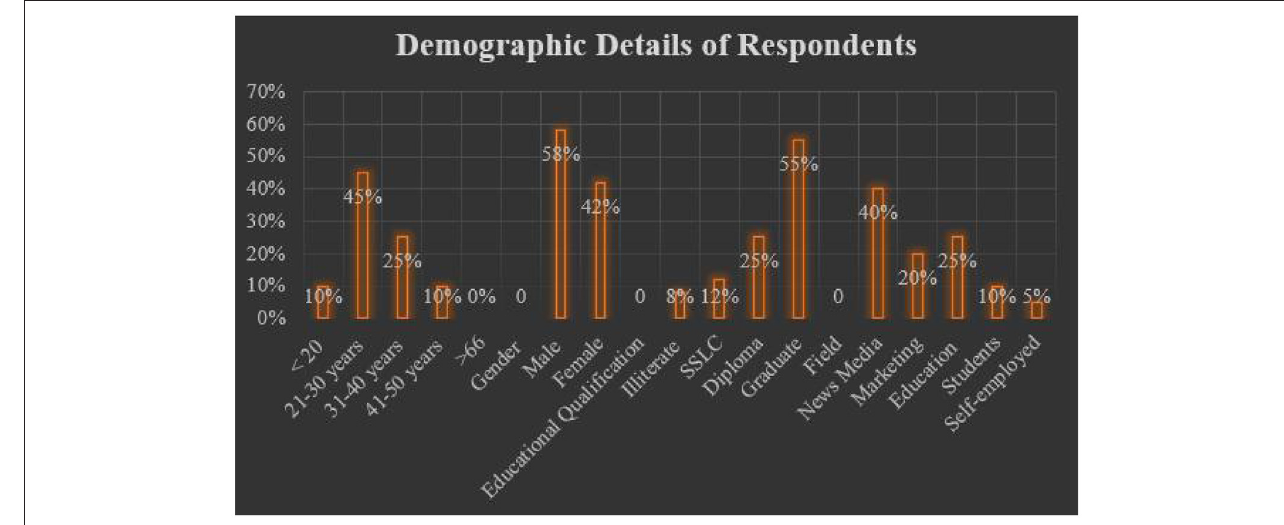
FIGURE 3 | Graphical representation of respondents’ details.